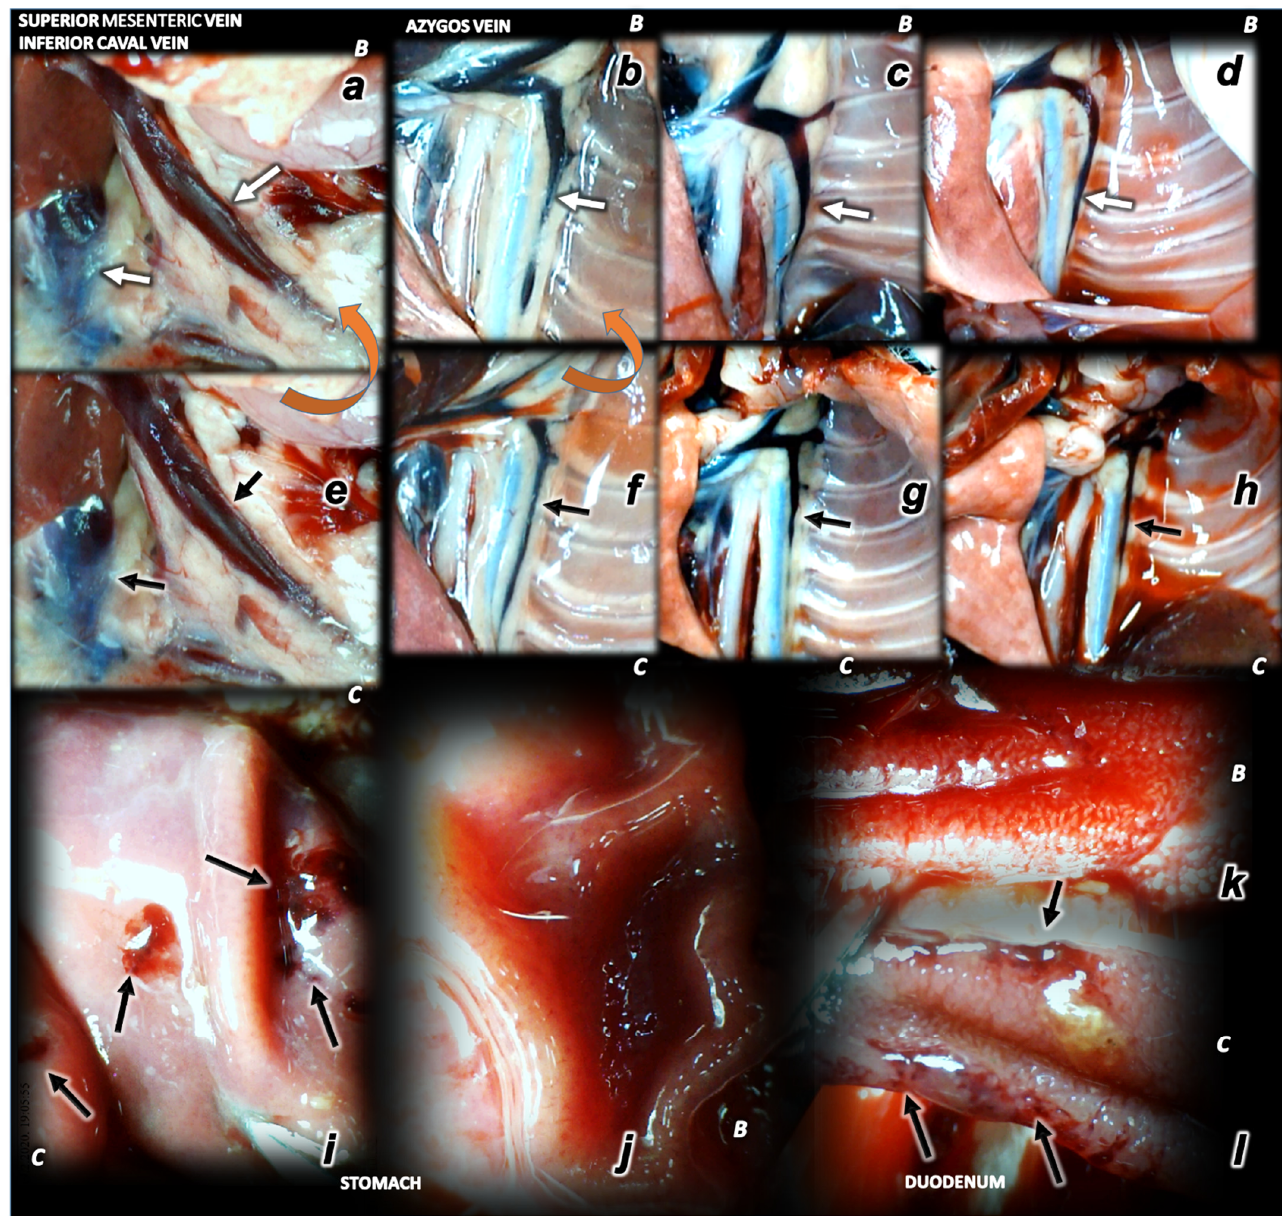
Figure 4. Illustrative presentation of blood vessels (superior mesenteric vein, inferior caval vein, azygos vein) ( a – h ), stomach and duodenal lesions ( i – l ). Rats received saline ( C ) or BPC 157 ( B ). Superior mesenteric vein, inferior caval vein ( a , e ), azygos vein ( b – d , f , g ). Upon superior sagittal sinus ligation, as illustration of the severe portal and caval hypertension, and not functioning connective pathways, congested superior mesenteric and inferior caval vein (arrows) ( e ), collapsed azygos vein (arrows) ( f ). Azygos vein remains weakly presented at 24 h (azygos vein, low, middle, ( g )) and 48 h ligation time (azygos vein, low, right, ( h )). Upon BPC 157 intragastric application, superior mesenteric and inferior caval veins are rapidly decongested ( a ) and azygos vein reopen (arrows) (upper, left, ( b )) sustainably presented also at 24 h (azygos vein, upper, middle ( c )) and 48 h ligation time (azygos vein, upper, right ( d )) (the effect along with elimination of the portal/caval hypertension, and elimination of the intracranial hypertension). Low. At 15 min ligation time, hemorrhagic lesions in the duodenum (right ( l )) and stomach (left ( j )) of the control rats (arrows), and spared mucosa in the duodenum ( k ) and stomach ( i ) of the BPC 157 treated rats. Magnification ×30.